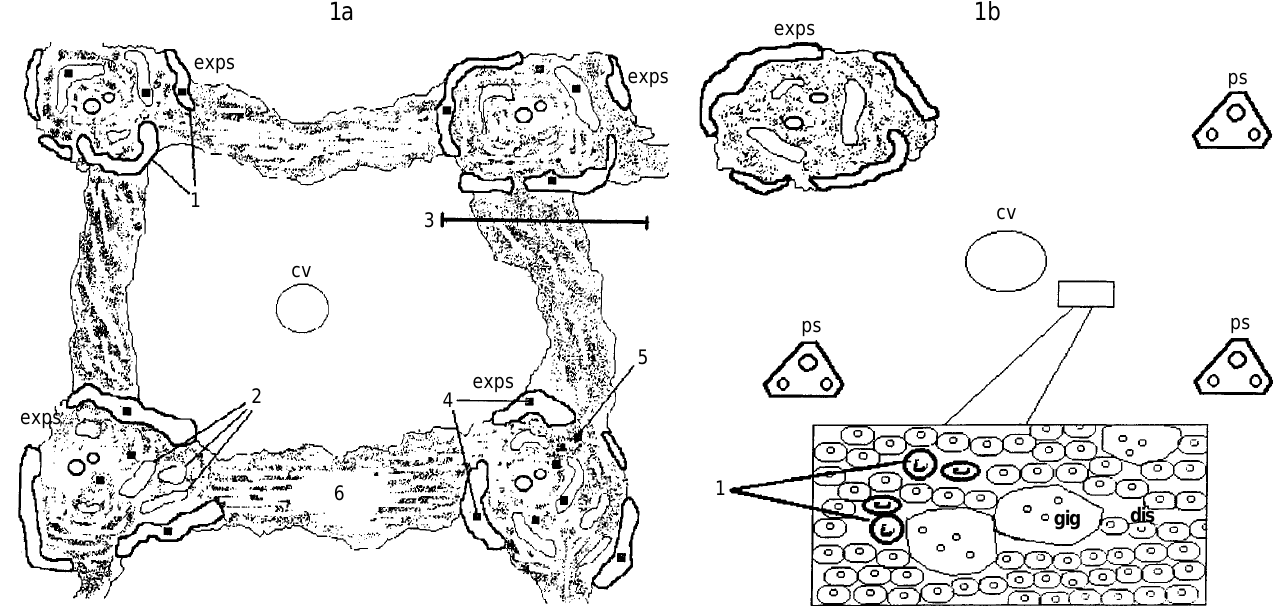
Figure 1 - Hepatic histopathological variables which indicate the intra- and extrahepatic forms of cholestasis in this study. 1a, Extrahepatic cholestasis: 1 - periportal ductal proliferation; 2 - portal ductal proliferation; 3 - portal expansion; 4 - cholestasis in neoductules; 5 - portal cholestasis; 6 - portal-portal bridges. 1b, Intrahepatic cholestasis: 1 - myeloid metaplasia. dis, Lobular disarray; ps, portal space; exps, expanded portal space; gig, gigantocytes; cv, central